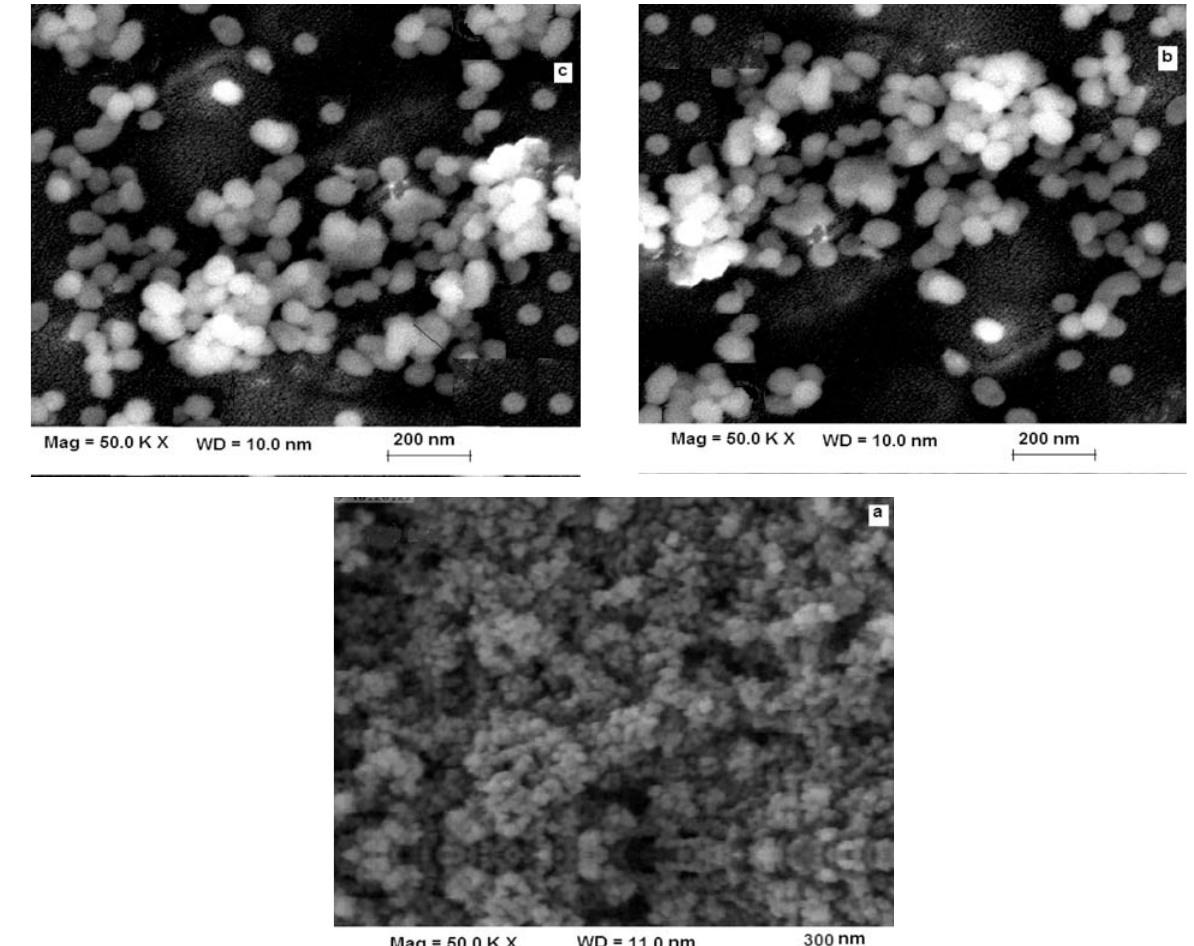
Fig. 3: SEM images of: (a) Al